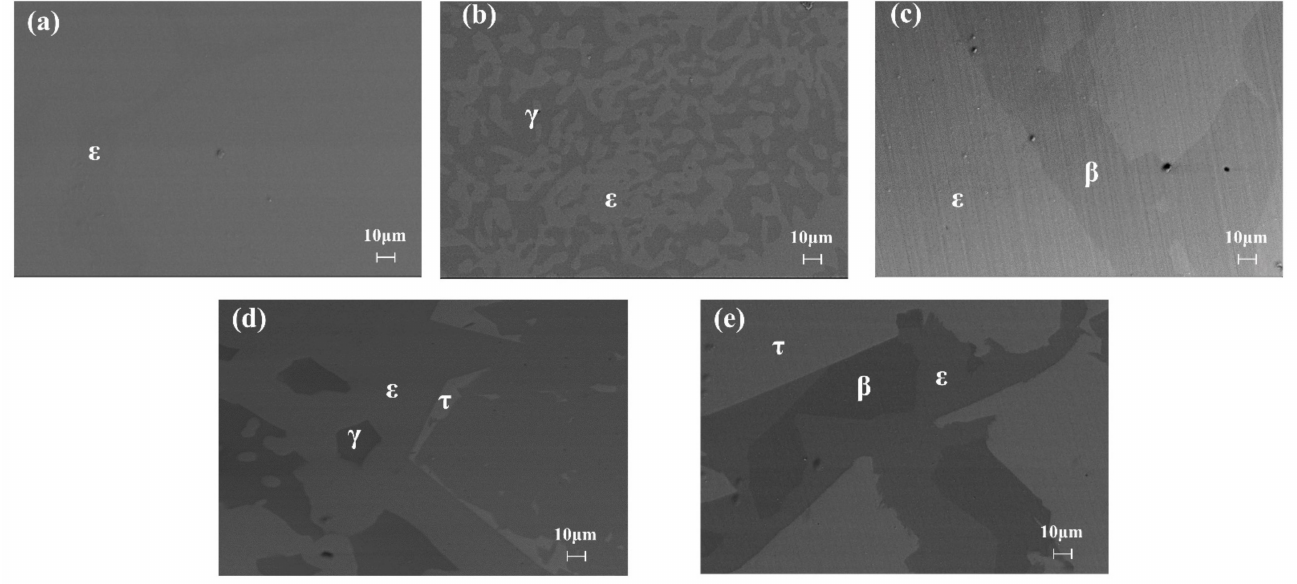
Figure 1. SEM images of samples annealed at 350 ◦ C for 305 h: ( a – e ) represent samples 1, 2, 3, 4, and 5, respectively.